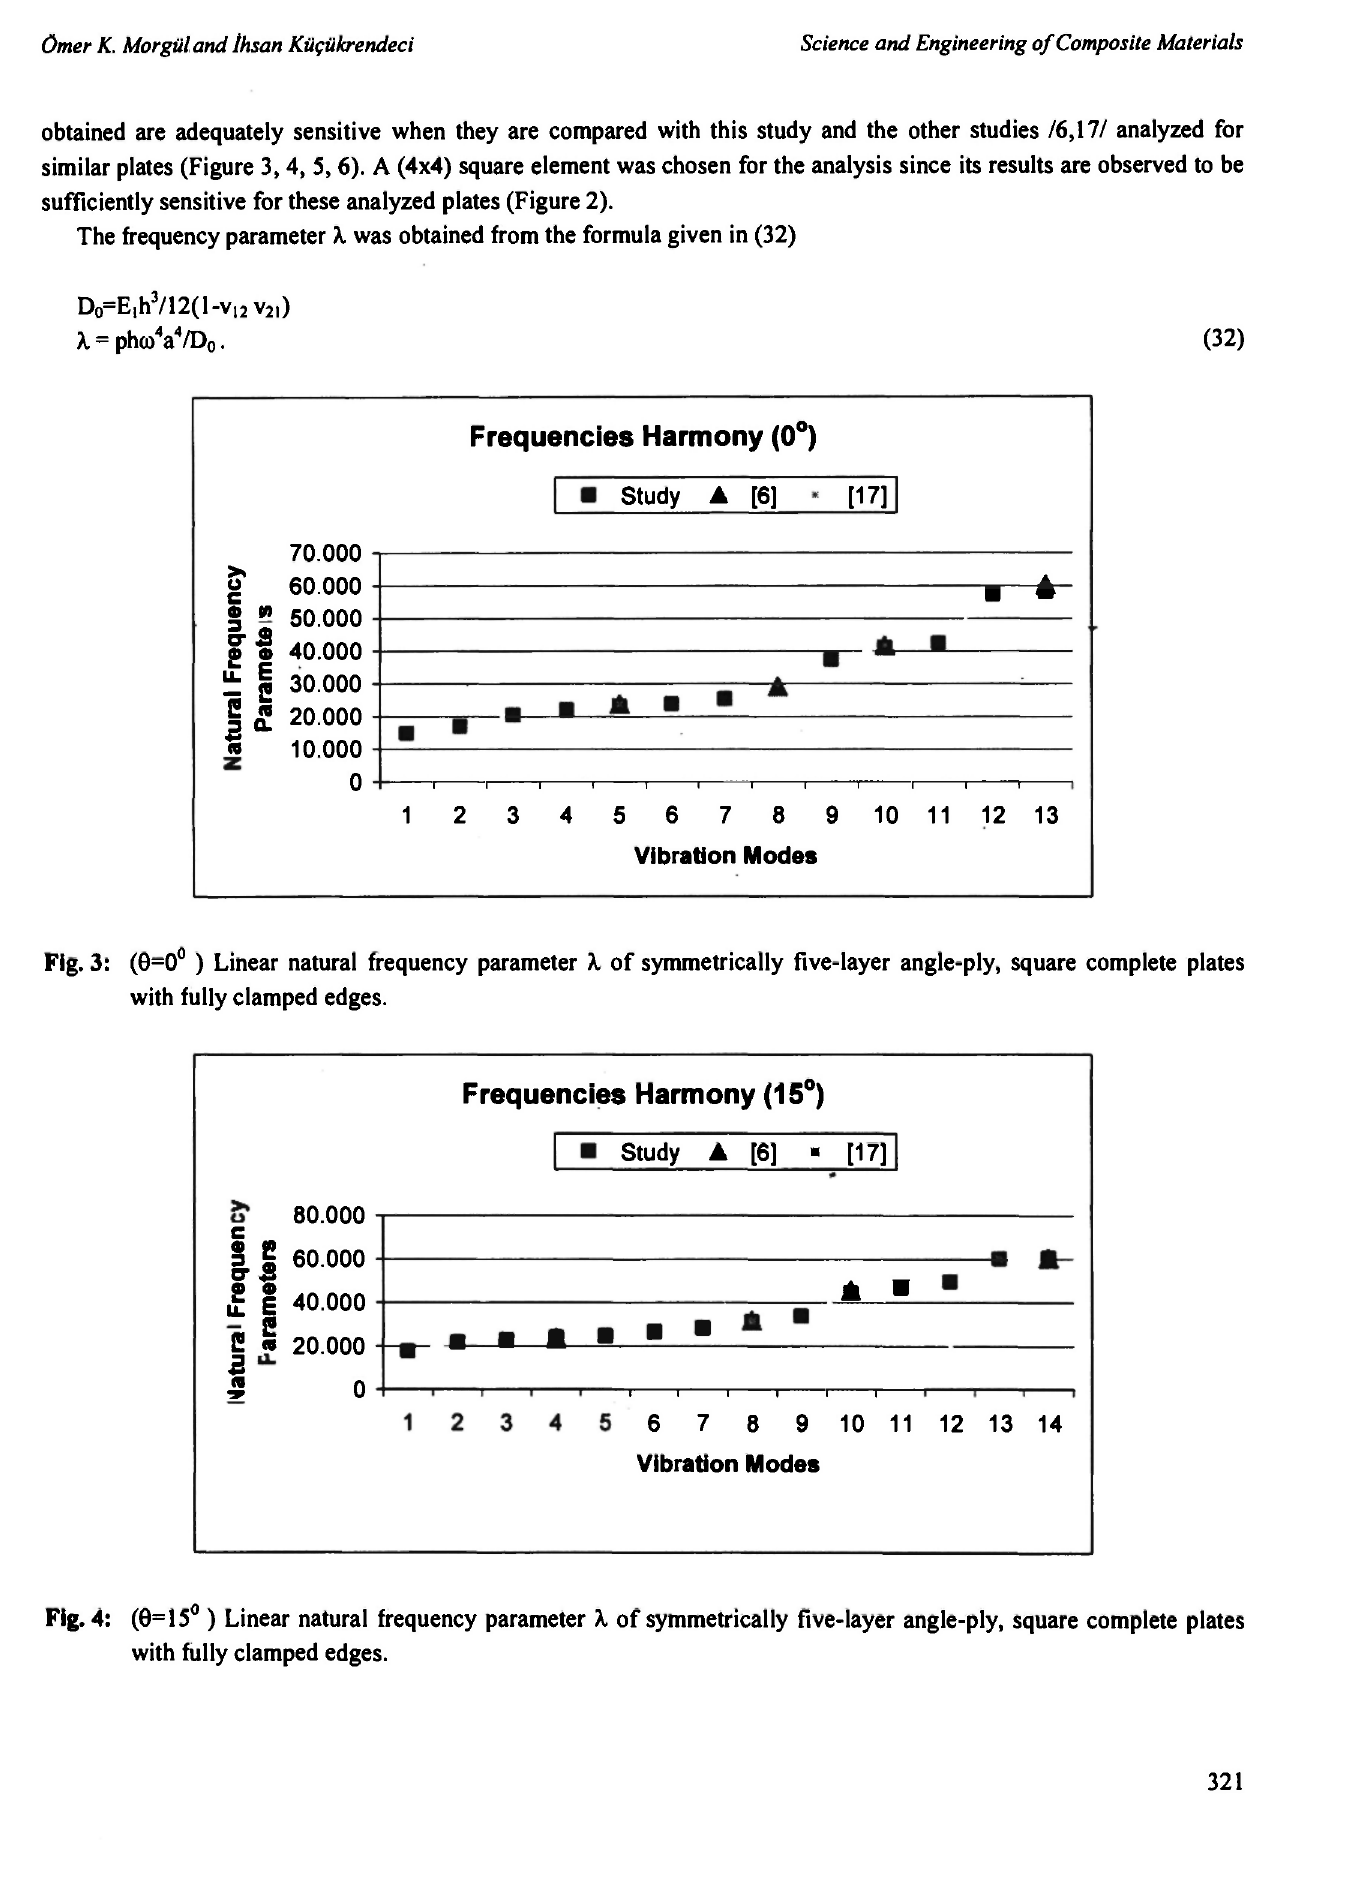
Fig. 3: (θ=0° ) Linear natural frequency parameter λ of symmetrically five-layer angle-ply, square complete plates with fully clamped edges.